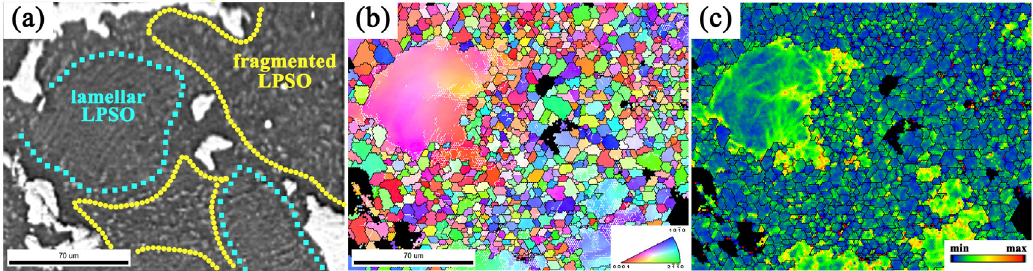
Figure 9. The typical regions with a large lamellar phase and fragmented lamellar phase: ( a ) SEM image; ( b ) OIM map; ( c ) KAM distribution map.